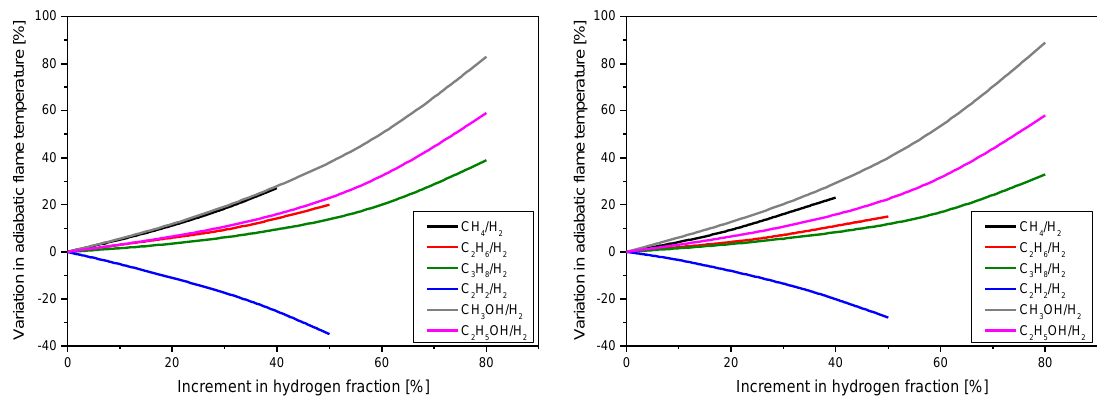
Figure 5. Variation in adiabatic flame temperature with increment in hydrogen fraction for lean ( Left ) and stoichiometric ( Right ) compositions.